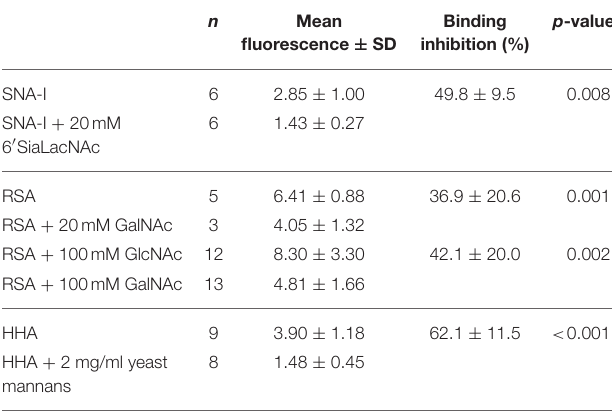
TABLE 2 | Inhibitory effect of carbohydrates on the binding of different lectins to the apical membrane of columnar cells from the larval midgut of Spodoptera littoralis . n Mean p Binding fluorescence ± SD inhibition (%)